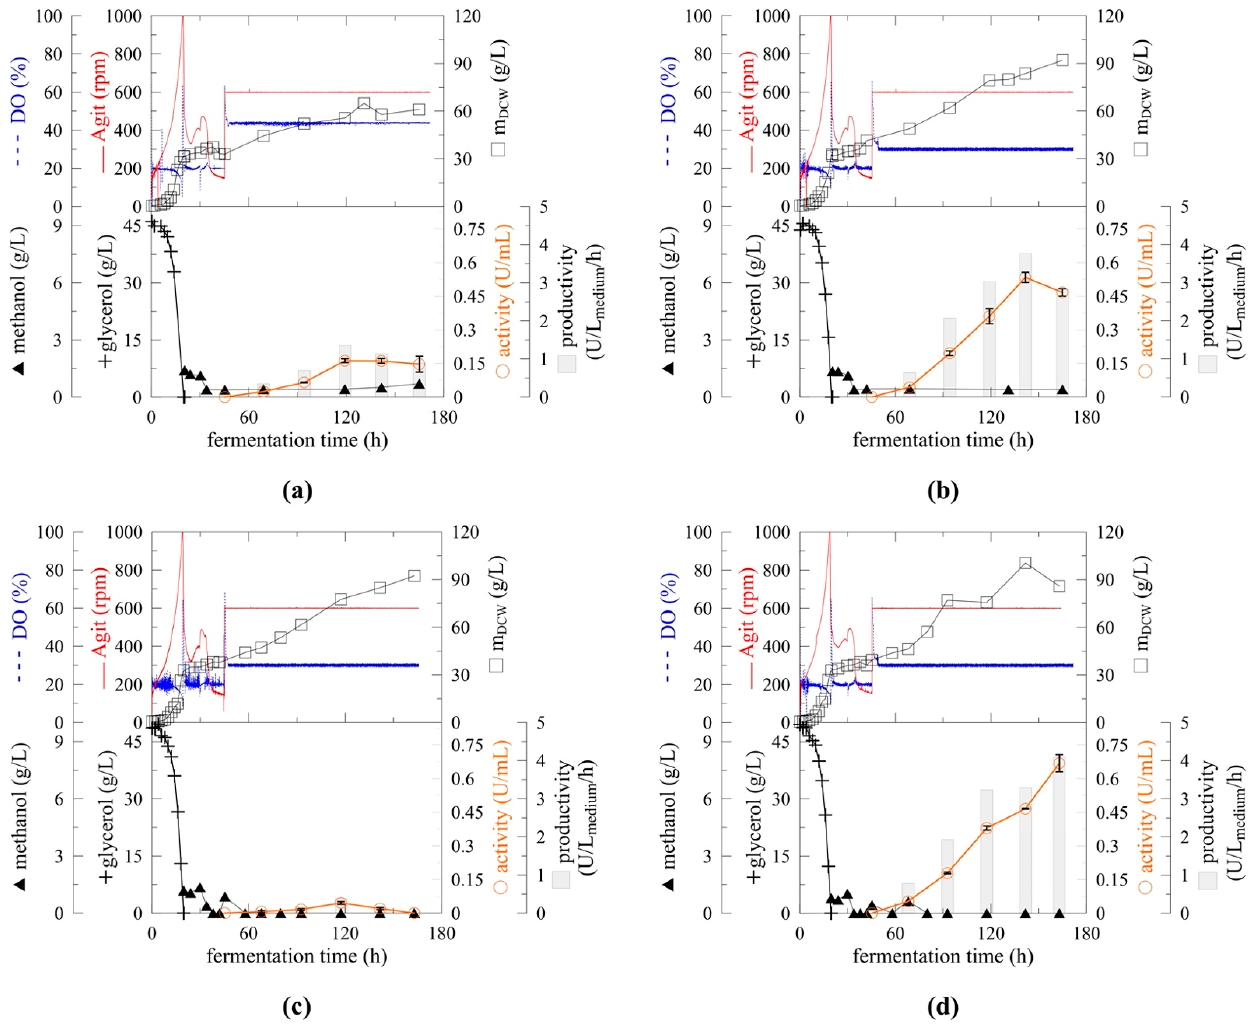
Figure 4. Temperature and pH optimisation of upscaled high-cell density cultivation of Pichia pastoris expressing myrosinase. Fermentation of P. pastoris KM71H (Mut S ) expressing At TGG1 myrosinase at 30 ( a ) and 20 °C ( b ) at pH 5; and at pH 4 ( c ), and 6 ( d ) at 20 °C.